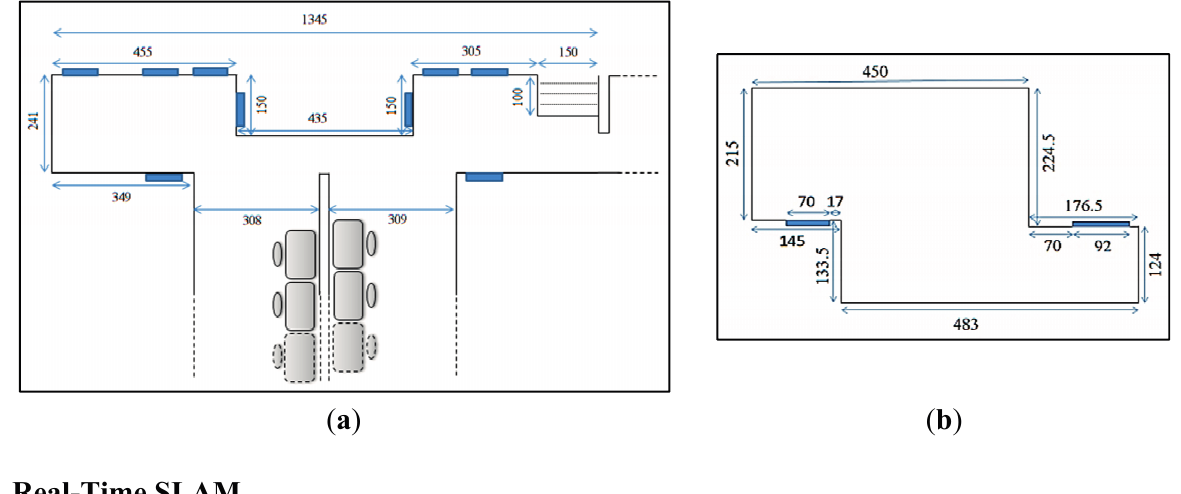
Figure 5. The map of the locations of SLAM experiments in CEASTech building, Unimap. ( a ) is a corridor with features ( i.e. , desks, chairs and stairs) while ( b ) is the small office room with no features. Dimensions shown are in